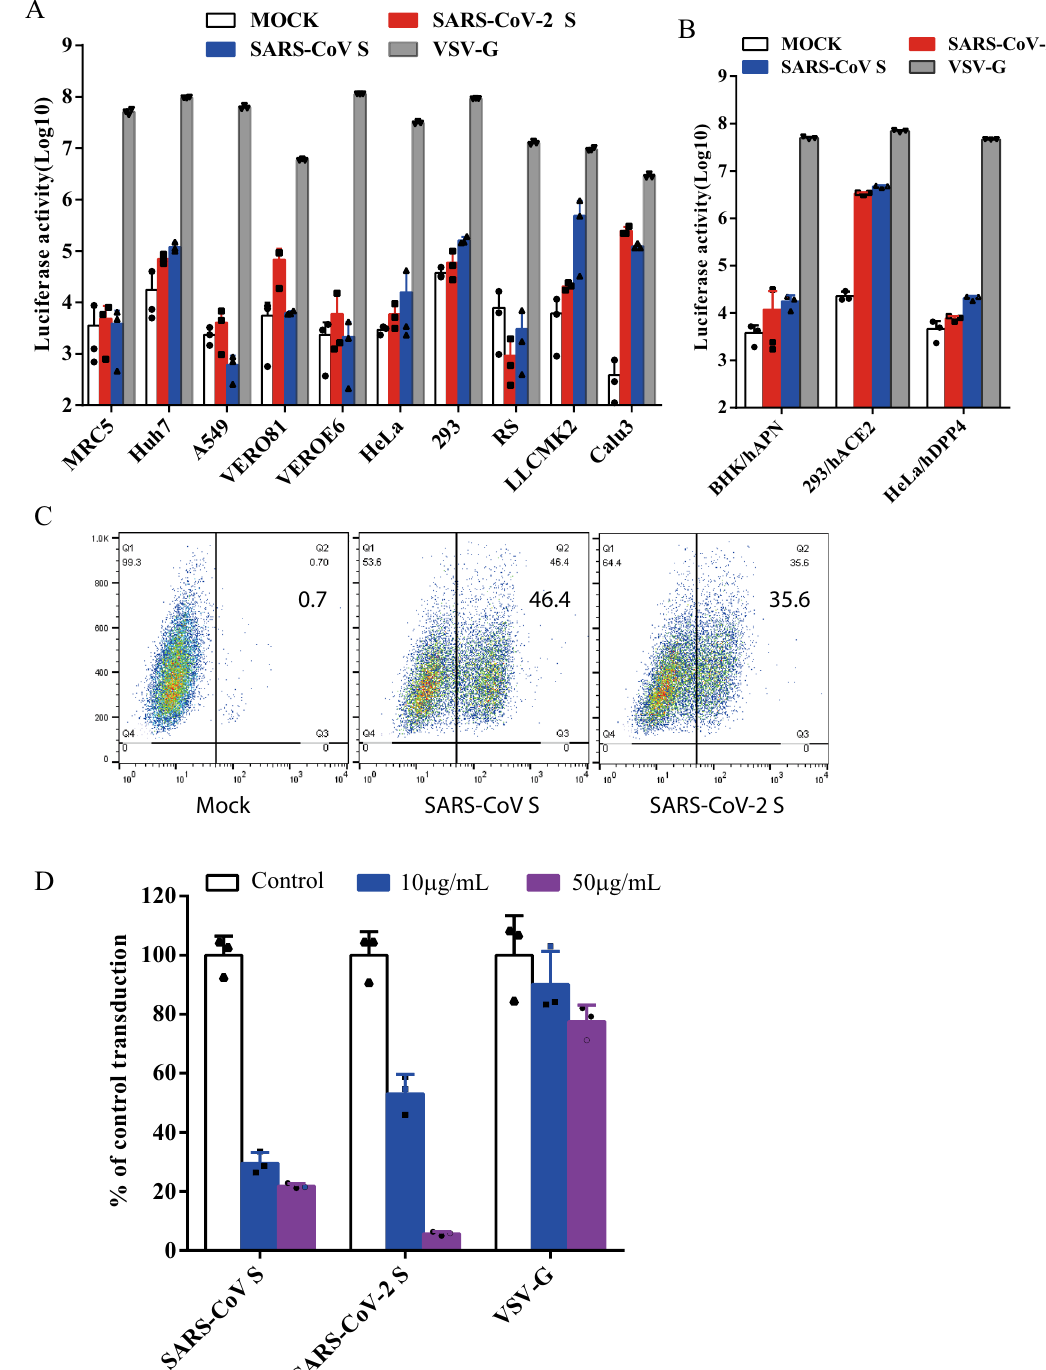
Fig. 2 Entry and receptor of SARS-CoV-2 S pseudovirons. a , b Entry of SARS-CoV-2 S pseudovirions on indicated cell lines. Cells from human and animal origin were inoculated with SARS-CoV-2 S (red), SARS-CoV S (blue), or VSV-G (gray) pseudovirions. At 48 h post inoculation, transduction ef fi ciency was measured according to luciferase activities. RS, Rhinolophus sinicus bat embryonic fi broblast; BHK/hAPN, BHK cells stably expressing hAPN, the hCoV-229E receptor; 293/hACE2, 293 cells stably expressing hACE2, the SARS-CoV receptor; HeLa/hDPP4, HeLa cells stably expressing hDPP4, the MERS-CoV receptor. Experiments were done in triplicates and repeated at least three times. One representative is shown with error bars indicating SEM. c Binding of SARS-CoV S and SARS-CoV-2 S proteins to soluble hACE2. HEK293T cells transiently expressing SARS-CoV and SARS-CoV-2 S proteins were incubated with the soluble hACE2 on ice, followed by polyclonal goat anti-hACE2 antibody. Cells were analyzed by fl ow cytometry. The experiments were repeated at least three times. d Inhibition of SARS-CoV-2 S pseudovirion entry by soluble hACE2. SARS-CoV S, SARS-CoV-2 S, or VSV-G pseudovirions were pre- incubated with soluble hACE2, then mixture were added to 293/hACE2 cells. Cells were lysed 40 h later and pseudoviral transduction was measured. Experiments were done twice and one representative is shown. Error bars indicate SEM of technical triplicates. Source data are provided as a Source Data fi